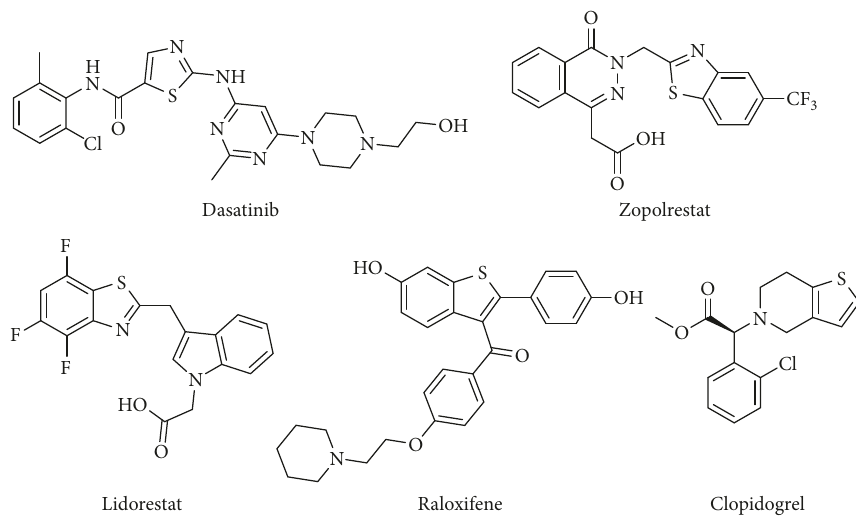
Figure 1: Some drugs containing thiazole, pyrimidine, or thiophene